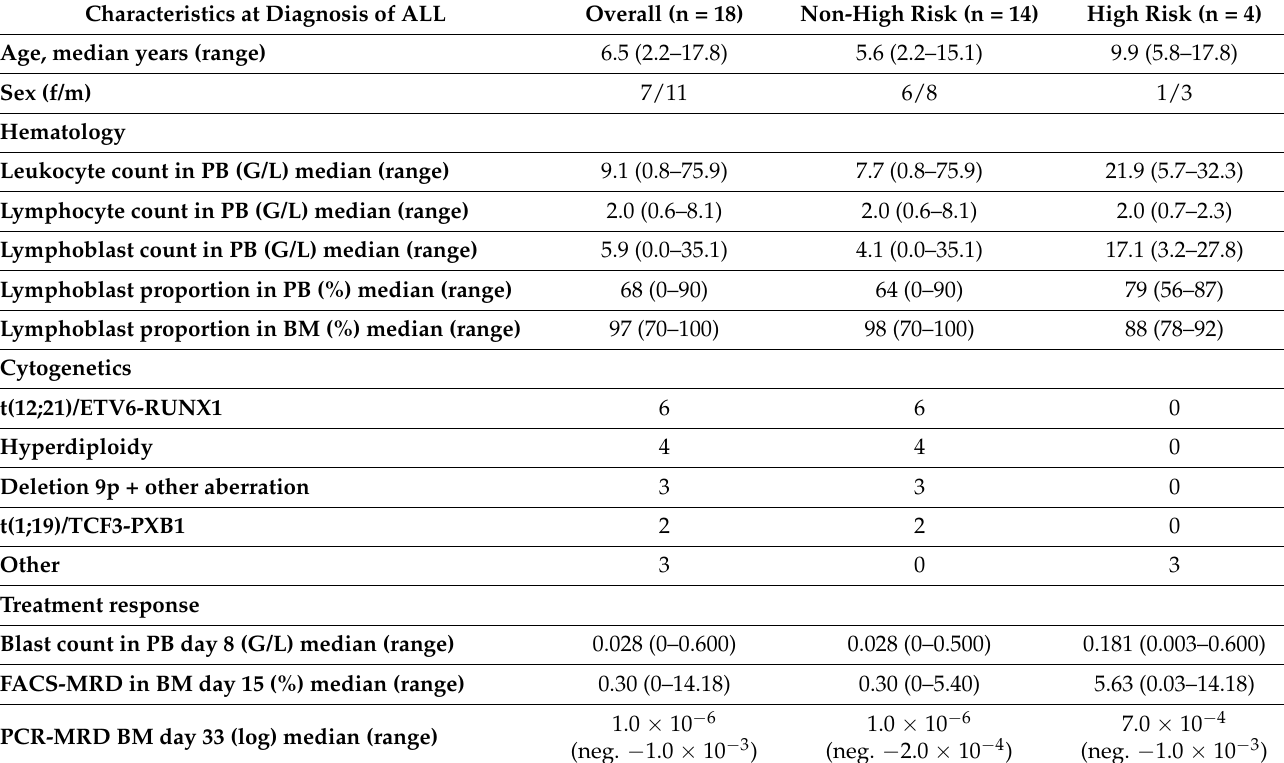
Table 1. Demographic, hematologic, cytogenetic, and response data of 18 pediatric patients with acute lymphoblastic leukemia